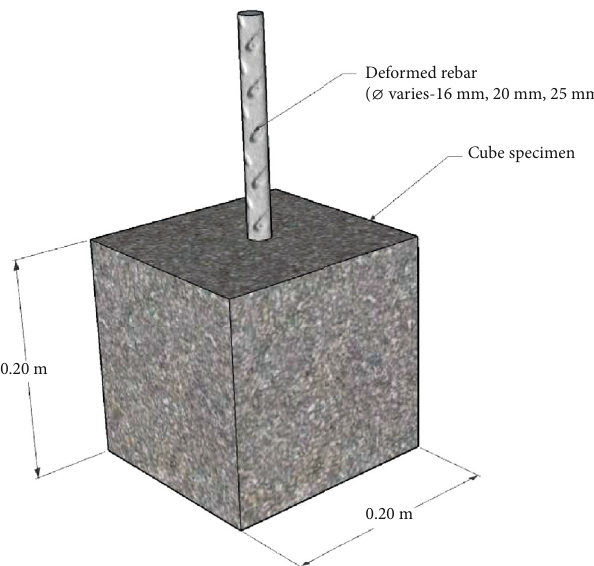
Figure 6: Scheme of cube